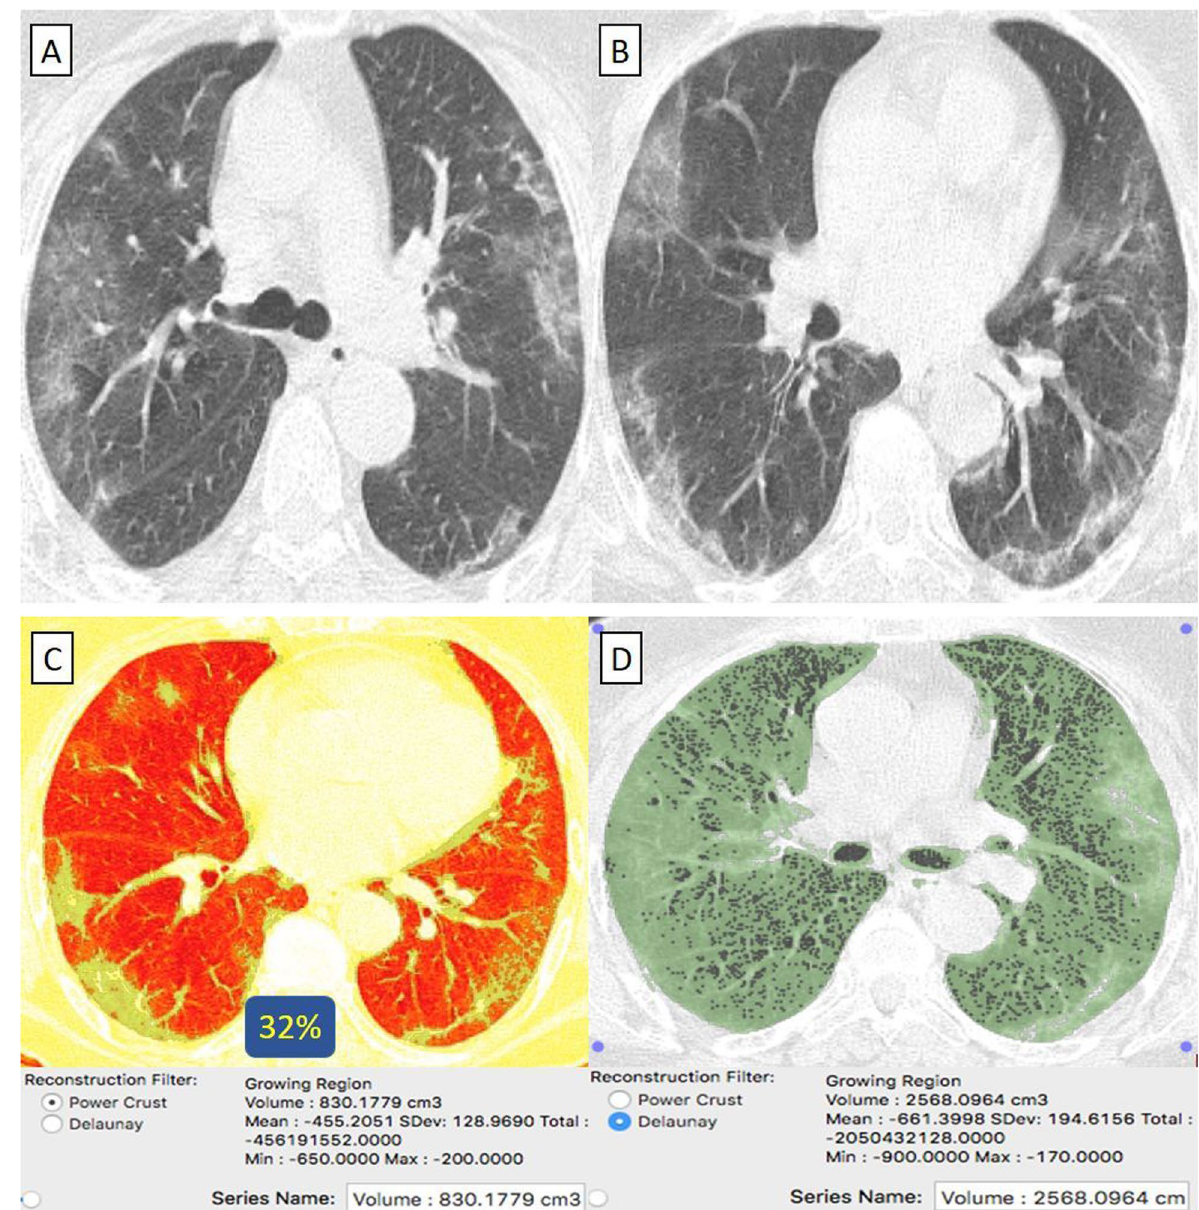
Fig. 3 A 55‑year‑old female patient with negative past medical history and had received “Sinopharm” vaccine then got COVID‑19 infection. A , B Axial chest CT cuts (lung window) showed bilateral mainly peripheral located ground‑glass pneumonic patches with peripheral sub‑pleural sparing (Atol‑sign). C CT‑Volumetry of the pathological lung parts averages 830 cc. D CT‑Volumetry of total lung volume averages 2568 cc. So, 32% of the lung parenchyma was diseased (Score